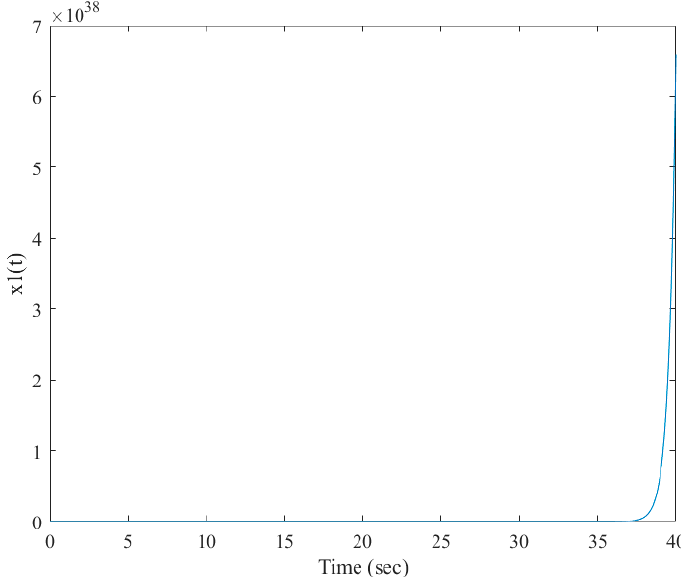
Figure 7. Response of 𝑥 (cid:2869) (cid:4666)𝑡(cid:4667) controlled by